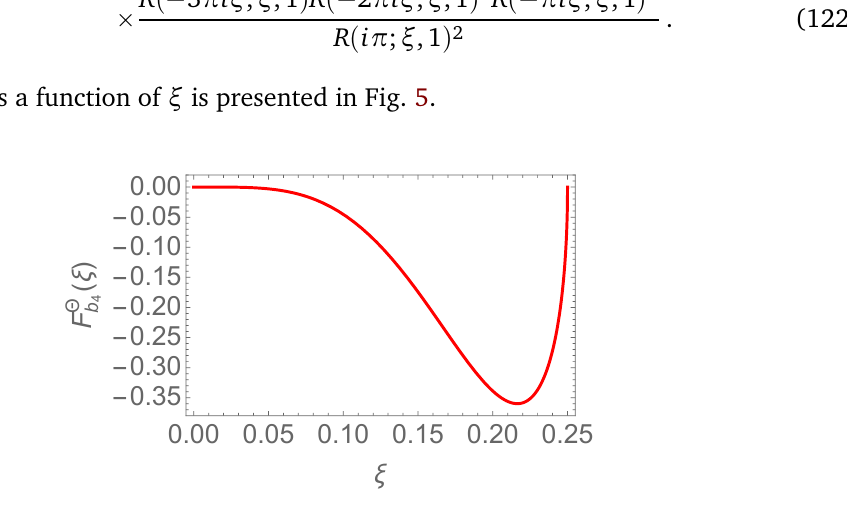
p ξ q for m “ b 4